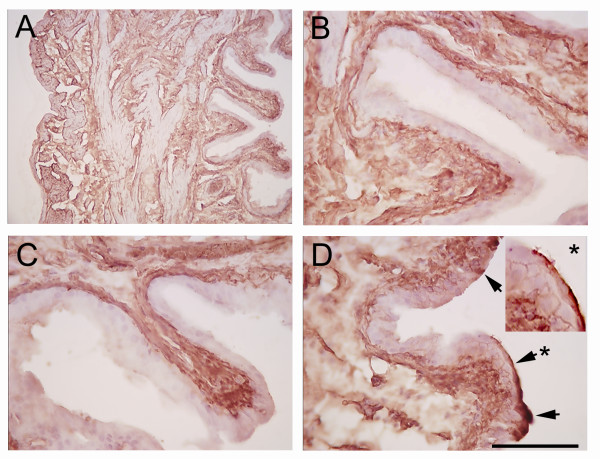
Substance P-induced A1-I3 immunostaining in umbrella cells. A1-I3 immunostaining in bladders from intact (A; B) and saline treated rats (C) showed A1-I3 in the interstitial spaces and in the lamina propria immediately below the urothelium, but not in the urothelium. In substance P-treated animals (D), however, A1-I3 immunostaining was detected in the urothelium, particularly on umbrella cells. Note also immunostaining surrounding (but not intracellular) in the basal and intermediate layers of the urothelium (see insert) in SP-treated rats. Calibration bar: A = 400 um; B, C, D = 100 um; insert = 50 um.